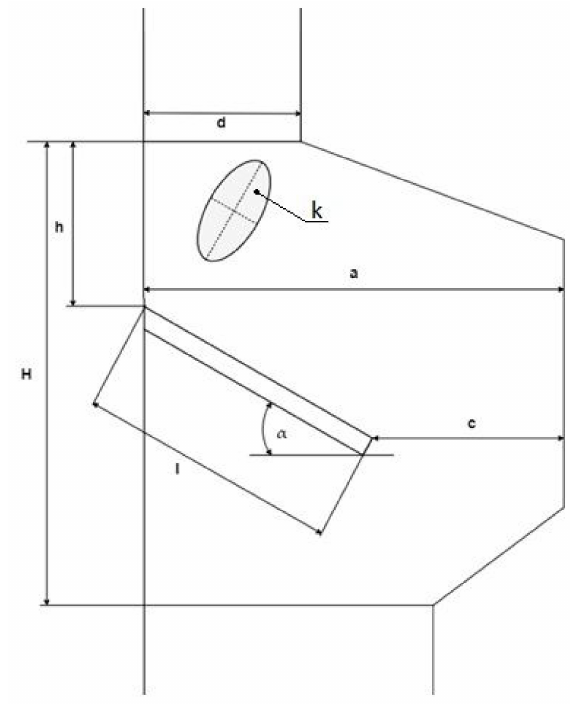
Figure 2. Scheme of a piezoelectric sensor chamber, d—grain exit hole diameter, h—distance between the highest point of the sensor mounting place, H—height of the chamber with sensor, l—length of piezoelectric sensor, c—length between the most protruding point of the sensor and the casing wall, α —tilt angle with the horizontal, a—width of the chamber with sensor,